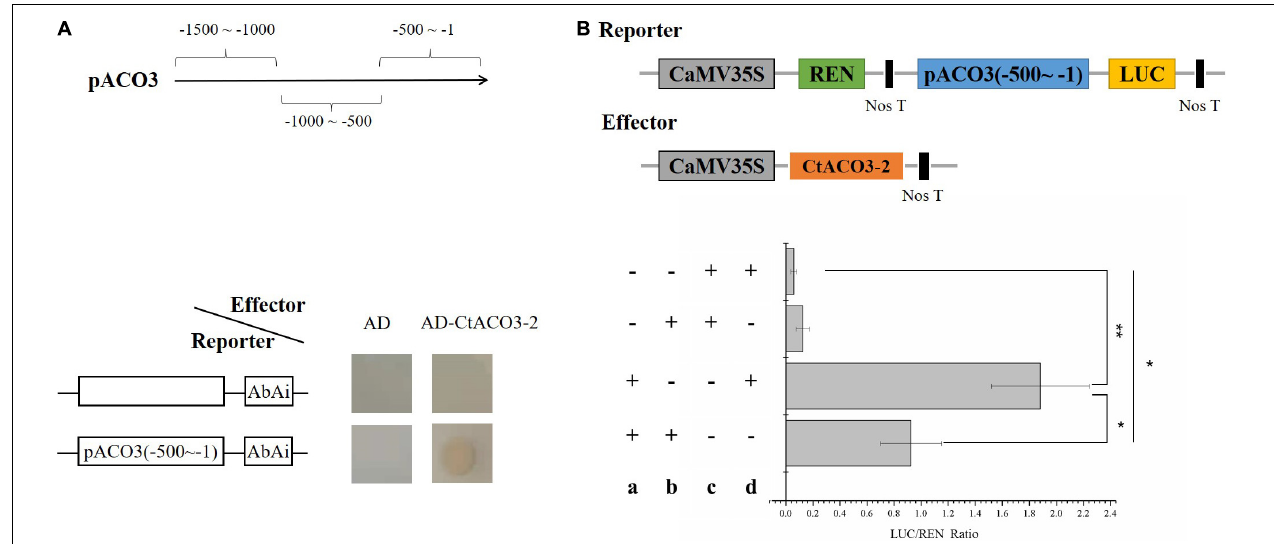
FIGURE 4 | Ct ACO3-2 regulate the transcription of CtACO3-1 . (A) Diagram of the promoter fragments of the CtACO3 promoter. Ct ACO3-2 binds to the -500 ∼ -1 fragment of CtACO3 promoter using Y1H assay. Y1H assays were repeated for three times. (B) The effects of Ct ACO3-2 on CtACO3 promoter deactivation. CtACO3 promoter p Ct ACO3 (-500 ∼ -1) was fused to LUC reporter and the promoter activity was determined by a transient Dual-LUC assay in N. benthamiana. The relative LUC activity was normalized to the reference Renilla (REN) luciferase. (a): Reporter, (b): effector, c: pGreenII0800-LUC, d: pGreenII 62-SK. Data were expressed as mean ± SD ( n = 3), ** p < 0.01, and * p <